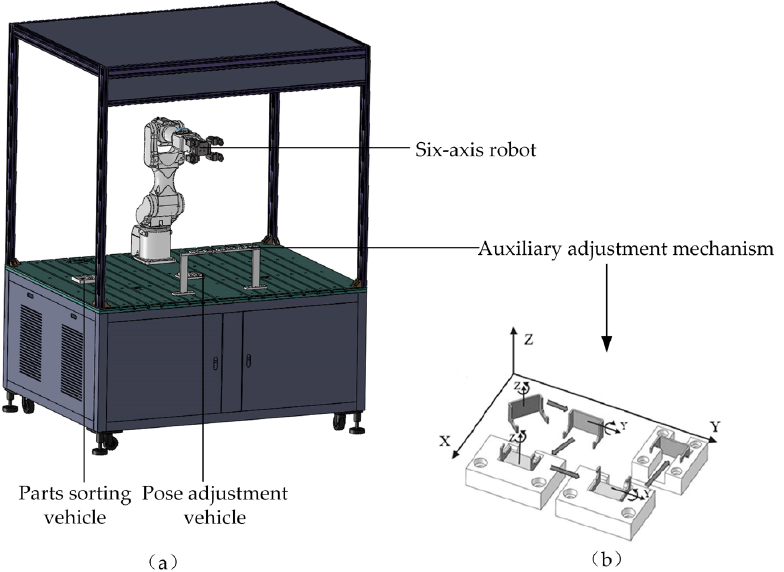
Figure 3. Single-robot flexible manufacturing system: ( a ) Crucial unit of parts’ posture adjustment; ( b ) Individual part attitude adjustment process.